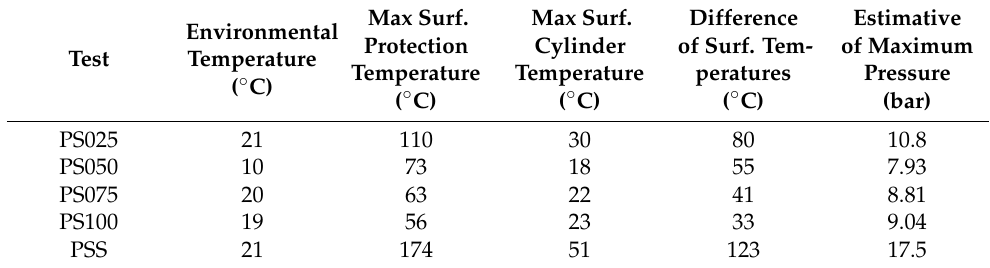
Table 4. Maximum surface temperatures of the tests and the estimative of the pressure in the cylinder. Max Surf. Max Environmental Test Temperature ( ◦ C)